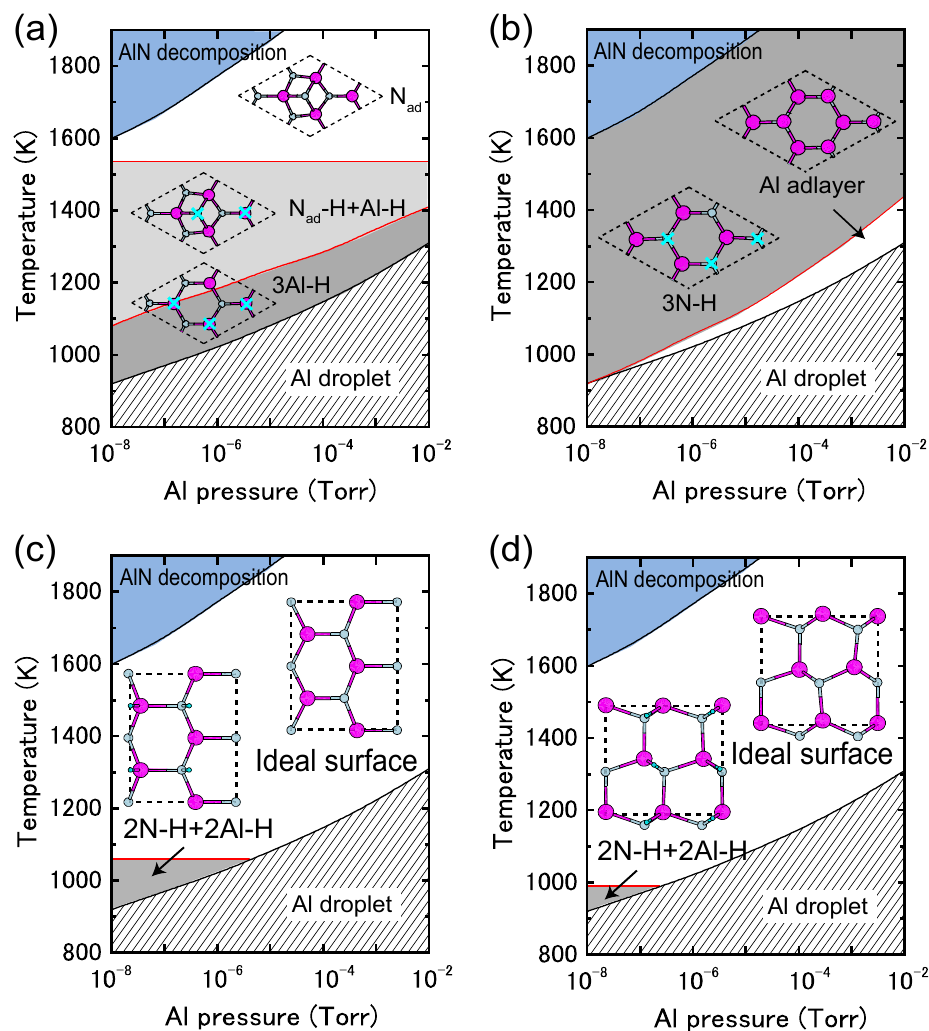
Figure 29. Calculated H-adsorbed AlN surface phase diagrams for polar ( a ) (0001) and ( b ) (cid:4666)0001(cid:3364)(cid:4667) and nonpolar ( c ) (cid:4666)11(cid:3364)00(cid:4667) and ( d ) (cid:4666)112(cid:3364)0(cid:4667) as a function of temperature and In BEP under high H pressure ( p = 76 Torr) conditions. Top surface structure views are 2 H2 also presented. Large and small circles represent Al and N atoms, respectively. The positions of H atoms in the H-terminated surfaces are marked by